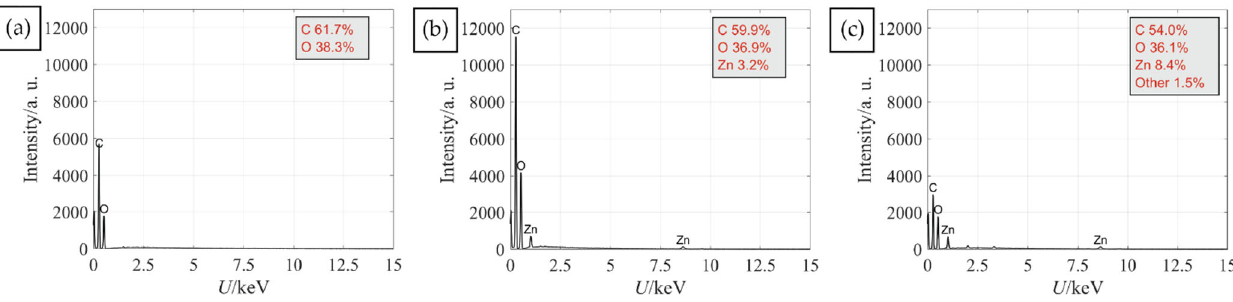
Figure 4. EDS spectra of untreated cotton sample ( a ) and cotton samples functionalised with proto ‐ col Ash + Extr + 0.1 ZnAc ( b ) and Ash + 0.1 ZnAc + Extr ( c ).